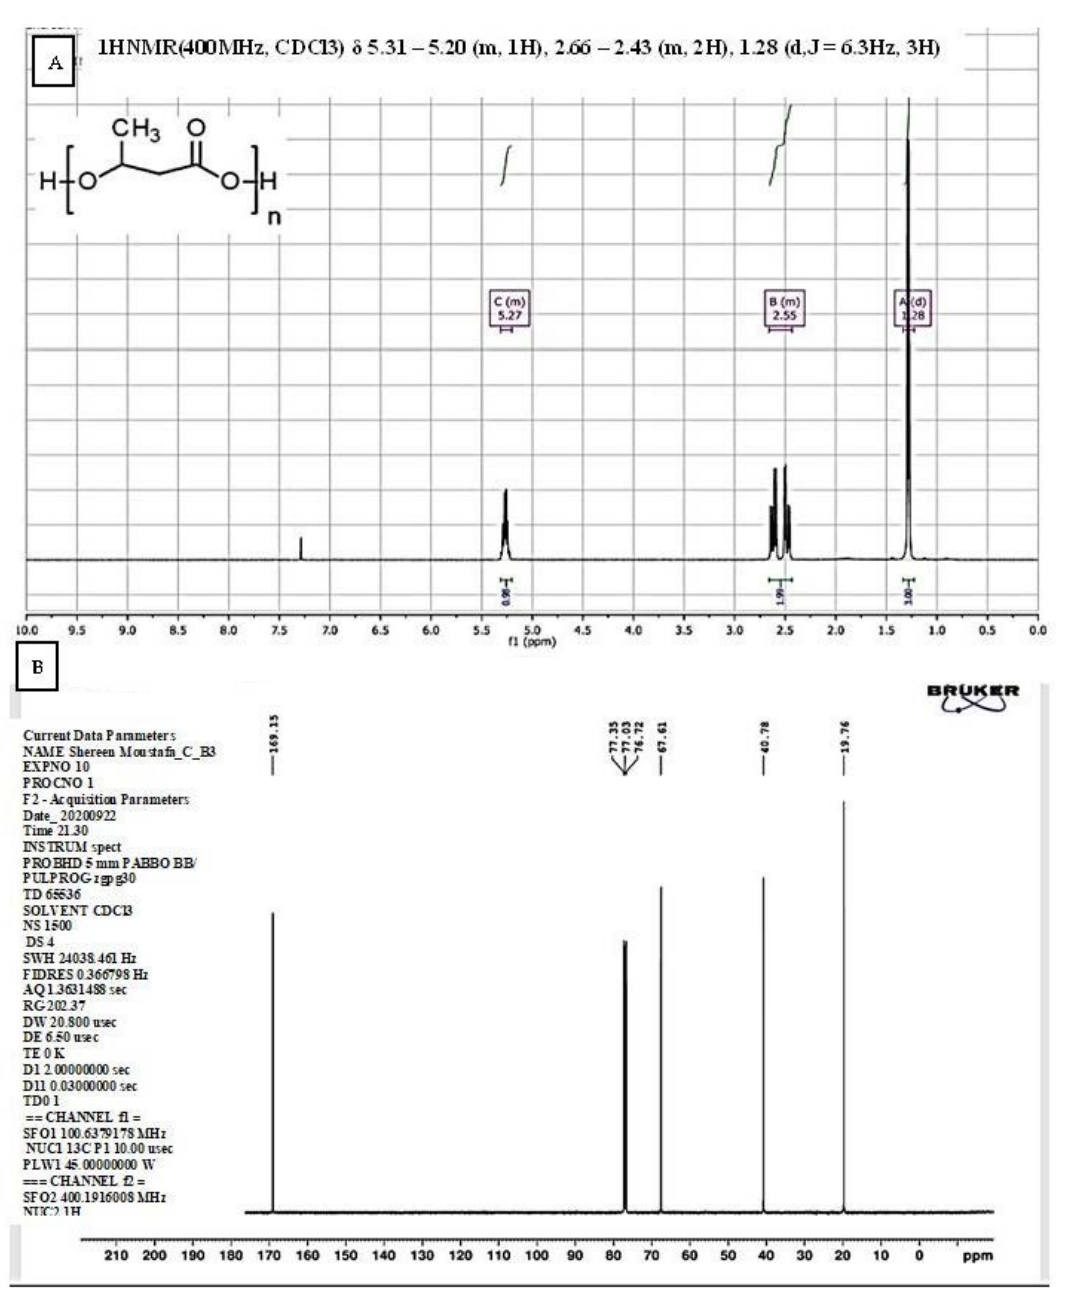
Figure 4. ( A ) 1 H NMR and ( B ) 13 C NMR spectra of polyhydroxybutyrates extracted from Bacillus wiedmannii strain.